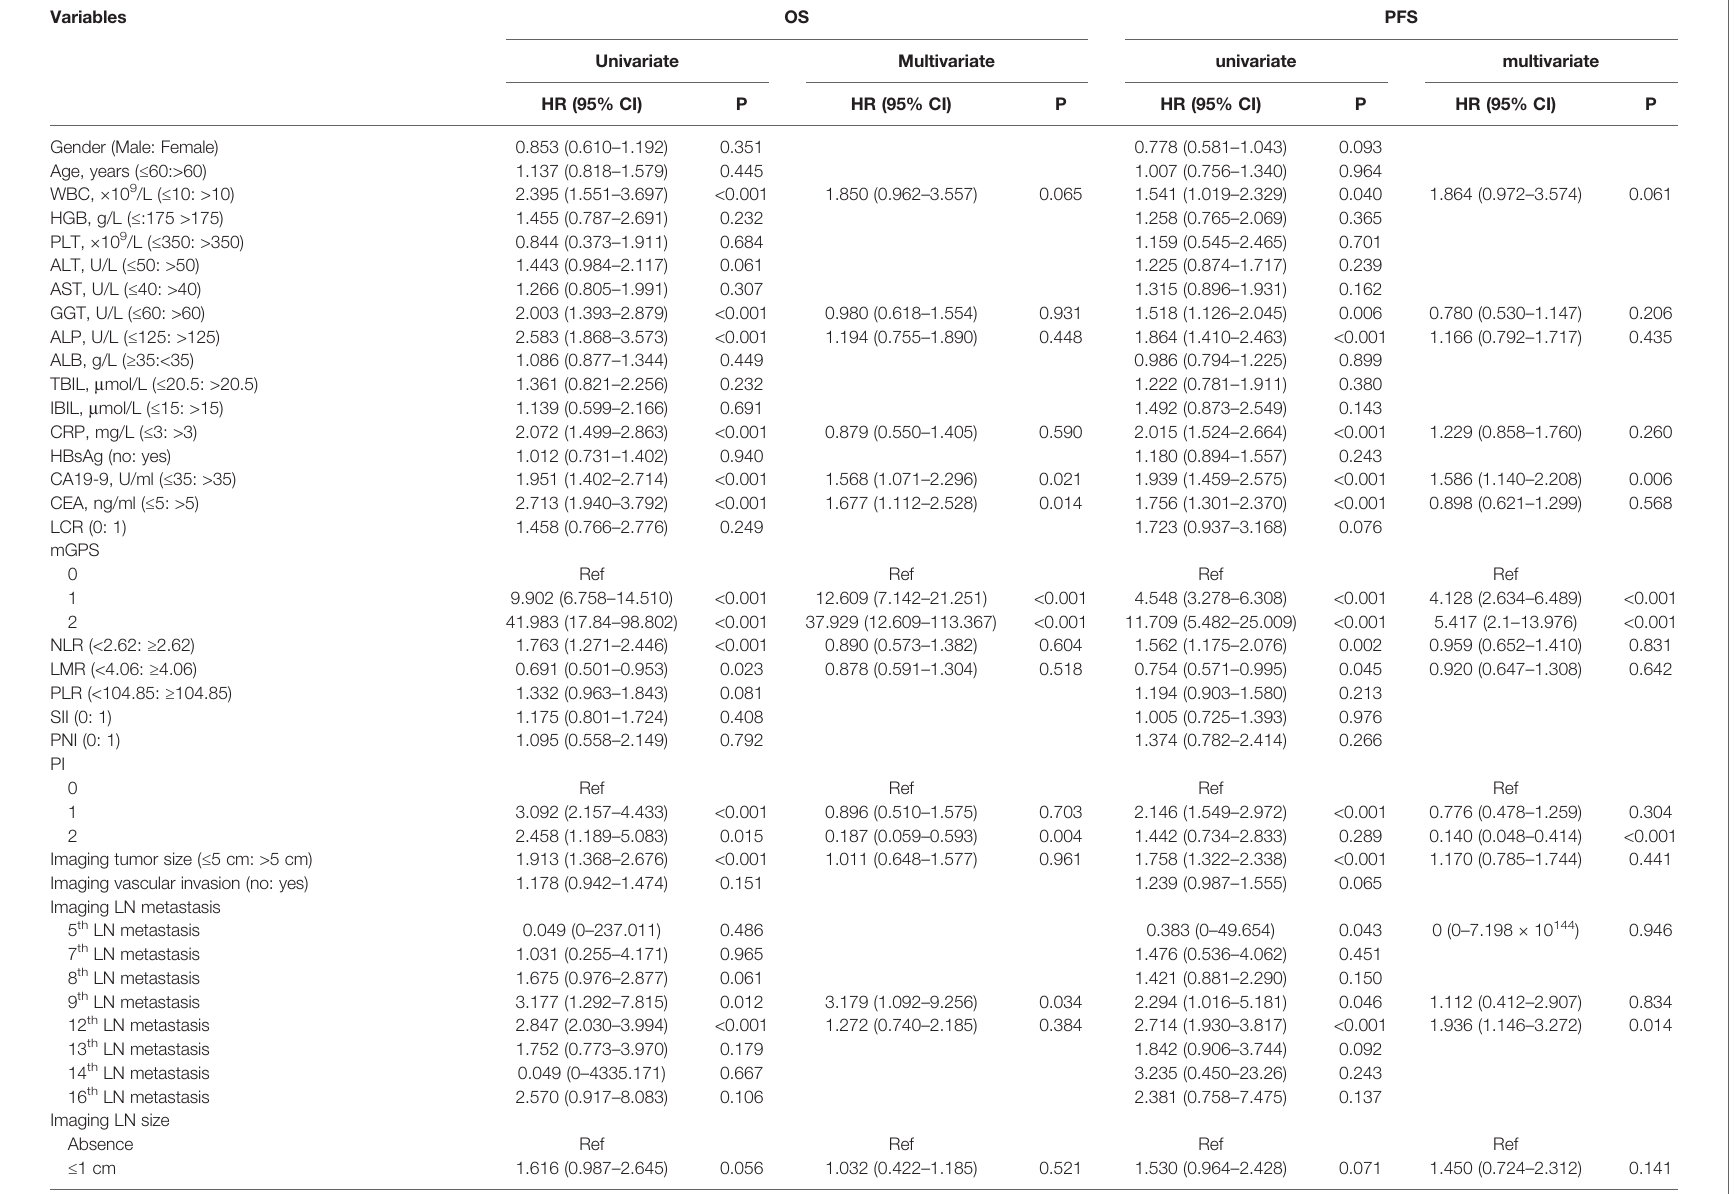
TABLE 3 | Univariate and multivariate analyses of prognostic factors of OS and PFS in the SYSUCC cohort. Variables